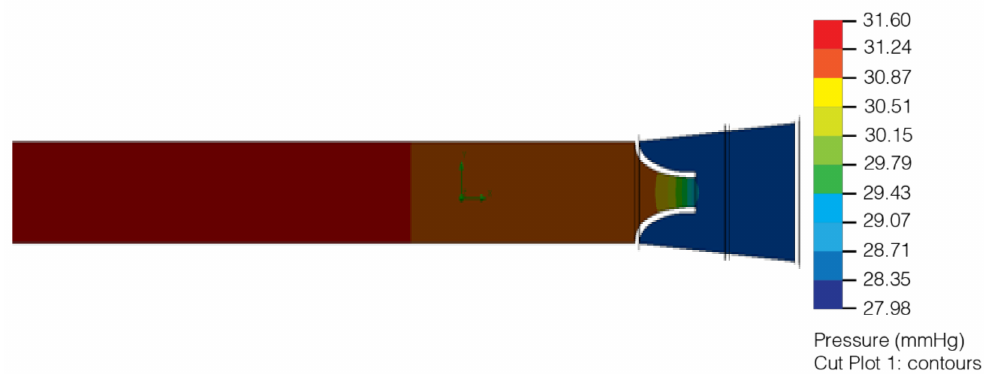
Figure 13. Liquid flow with pressure in open valve; it has a correct one-way direction